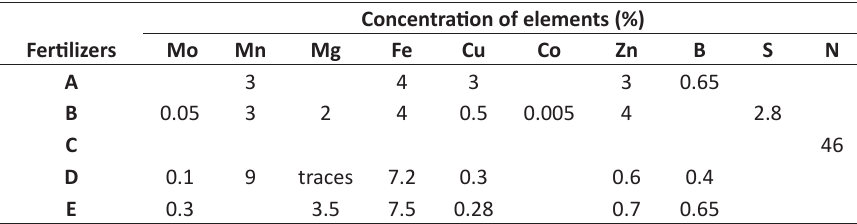
Table 1. Fertilizers used and their components in percentage. Concentration of elements (%) Fertilizers